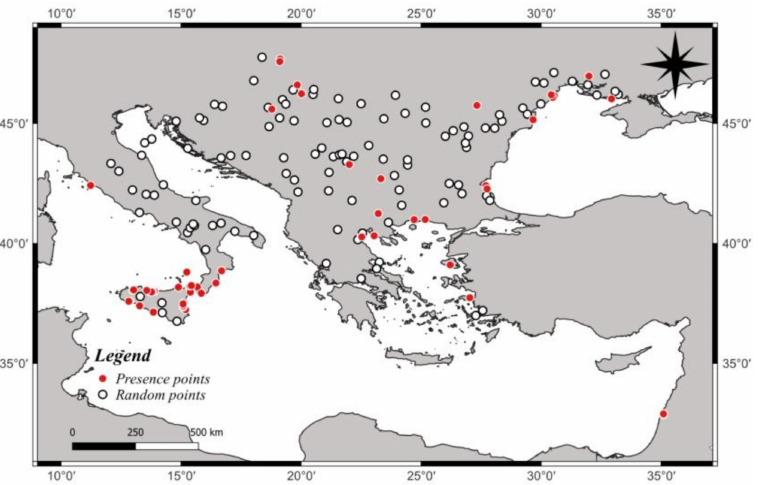
Figure 2. Distribution of the presence and random points of Anoxia orientalis in